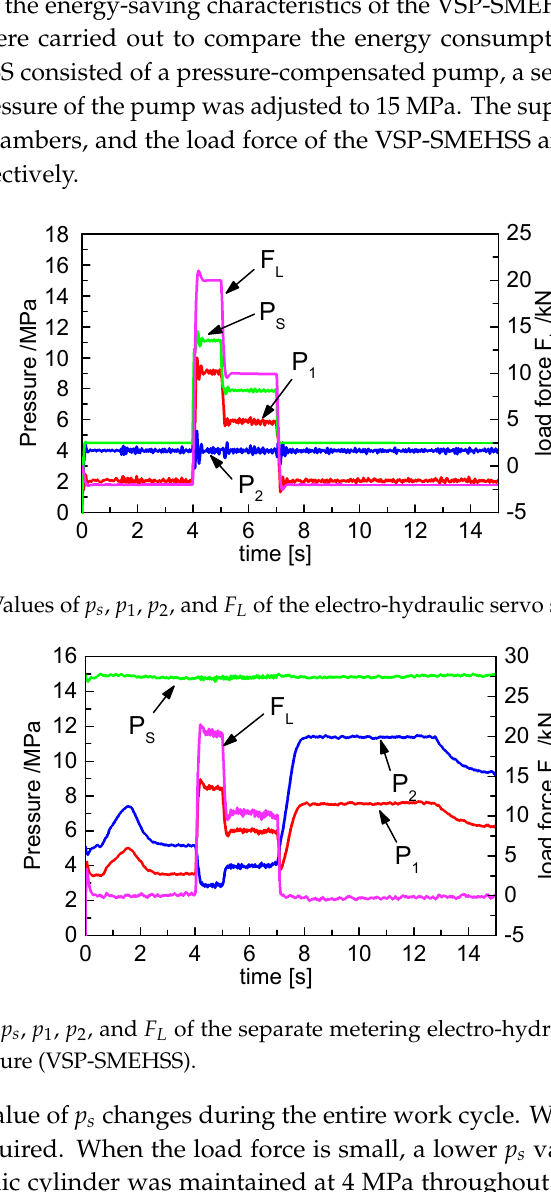
Figure 17. Values of p s , p 1 , p 2 , and F L of the separate metering electro-hydraulic servo system with varying supply pressure (VSP-SMEHSS).